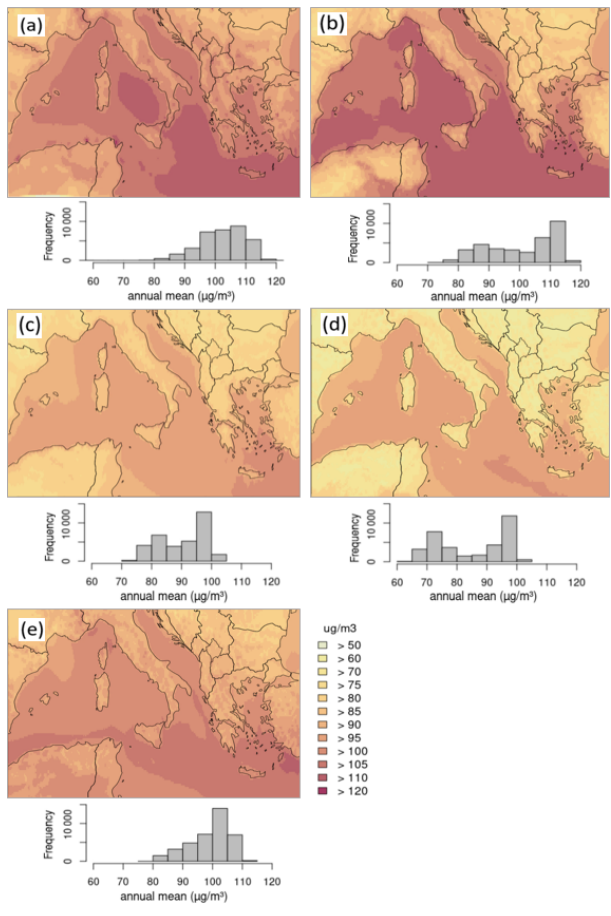
Figure 10. Annual mean O x ( = NO 2 + O 3 ) concentration. EUROS. Below the domain figure the respective frequency distri- bution is displayed for the annual mean O x concentration, referring to the whole model domain.